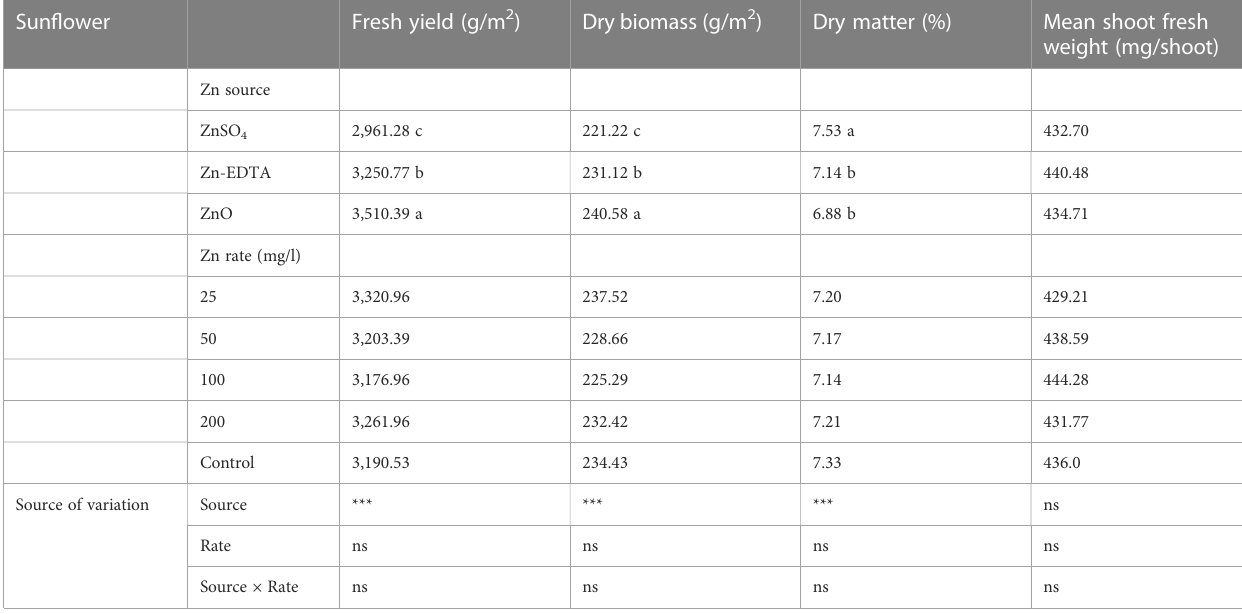
TABLE 2 Effects of seed soaking with different Zn sources and rate on fresh yield, dry yield, dry matter, and fresh weight/shoot of sun fl ower microgreens. 1 Sun fl ower